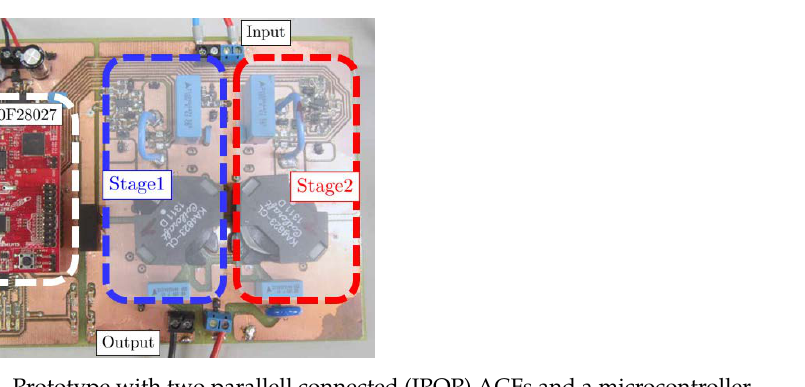
Figure 11. Prototype with two parallell connected (IPOP) ACFs and a microcontroller. Table 2. Main components that were used in the prototype.